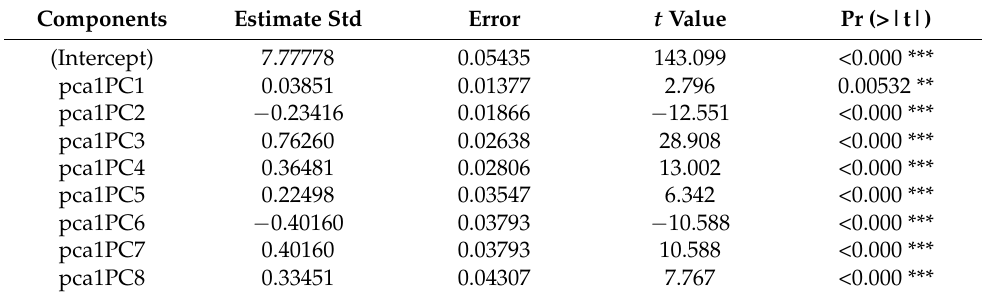
Table 7. Best teams linear regression